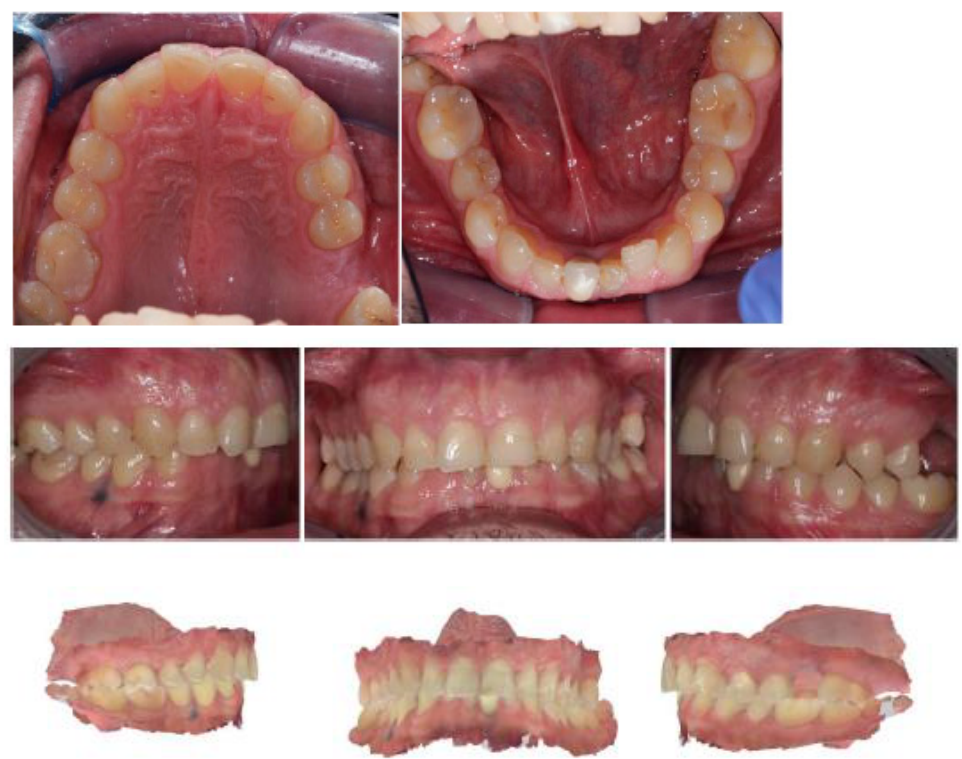
Figure 25. Intraoral views show increased overbite (4–5 mm), overjet of about 1 mm, class I molar on the right, class II canine on the right, and class I canine on the left. There is evidence of widespread wear facets and a mild gingival recession on tooth 33. The patient revealed pain on palpation of the right and left TMJs. Palpation of the masticatory muscles revealed pain in the lateral pterygoid muscle area, both right and left, and generalized discomfort of the masseter and suprahyoid muscles. Figure 26. Absence of element 26, implant-prosthesis of element 31, and condylar asymmetry. It was indicated to investigate the diagnostic with an X-ray of elements 36 and 46. The patient showed a small opening width, approximately 25 – 30 mm, without pain. Lateral movements were within the norm. MRI images of the TMJ show anterior displace- ment of the disc with reduction (Figure 27).